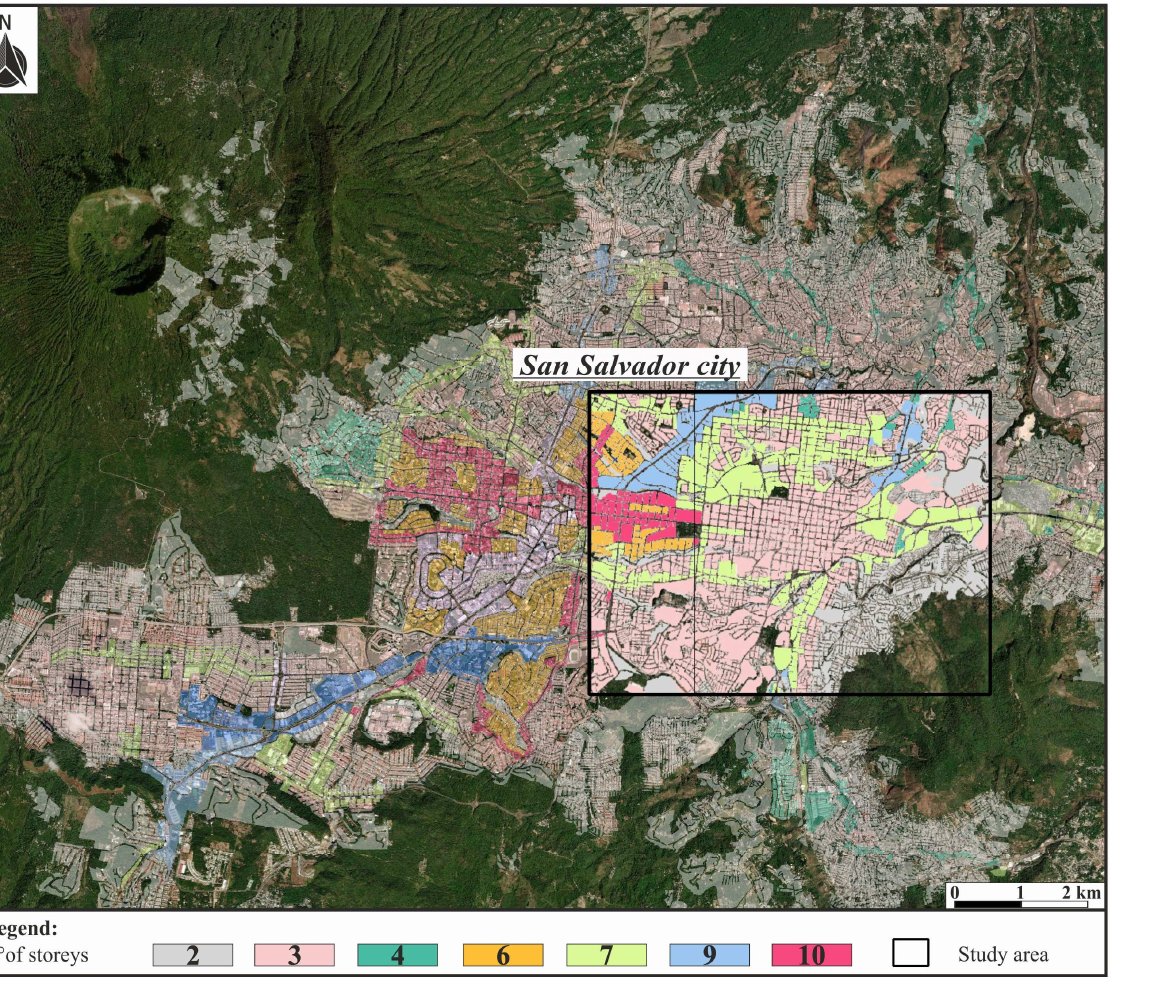
Figure 2. Areal distribution of the number of storeies within the municipality area of San Salvador. (after, [18], modified).